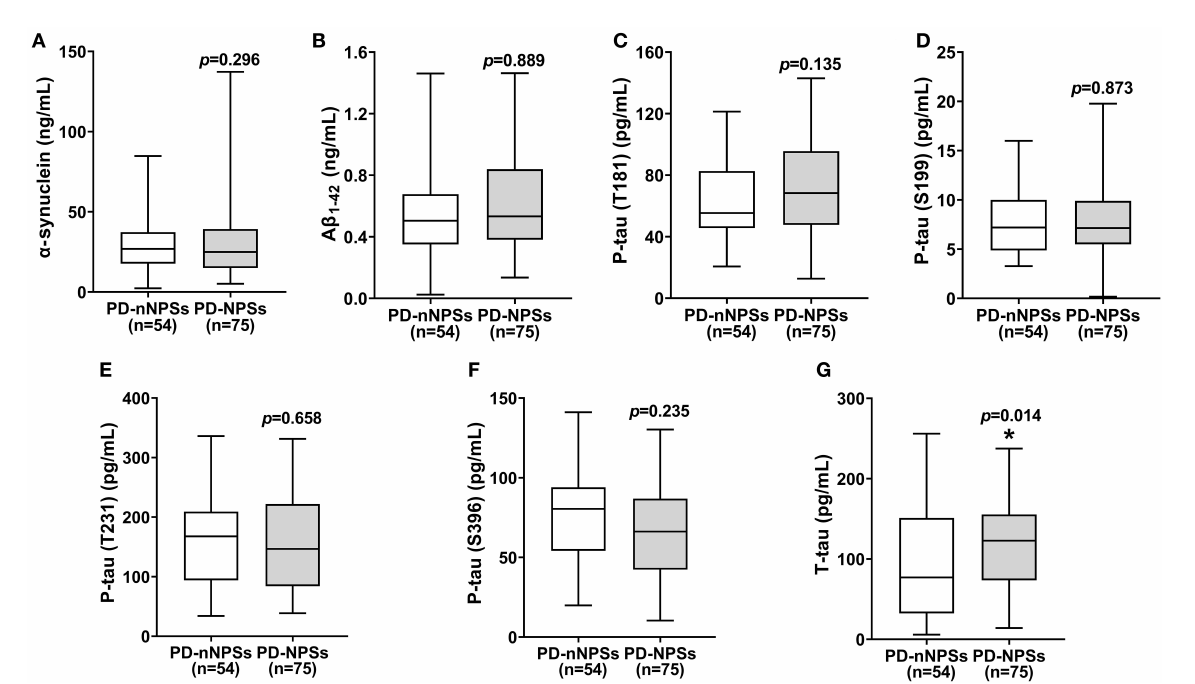
FIGURE3 (A–G) The levels of neuropathological proteins in CSF were compared between PD-NPSs group and PD-nNPSs group. It was showed that T-tau level in CSF from PD-NPSs group was significantly higher than that from PD-nNPSs